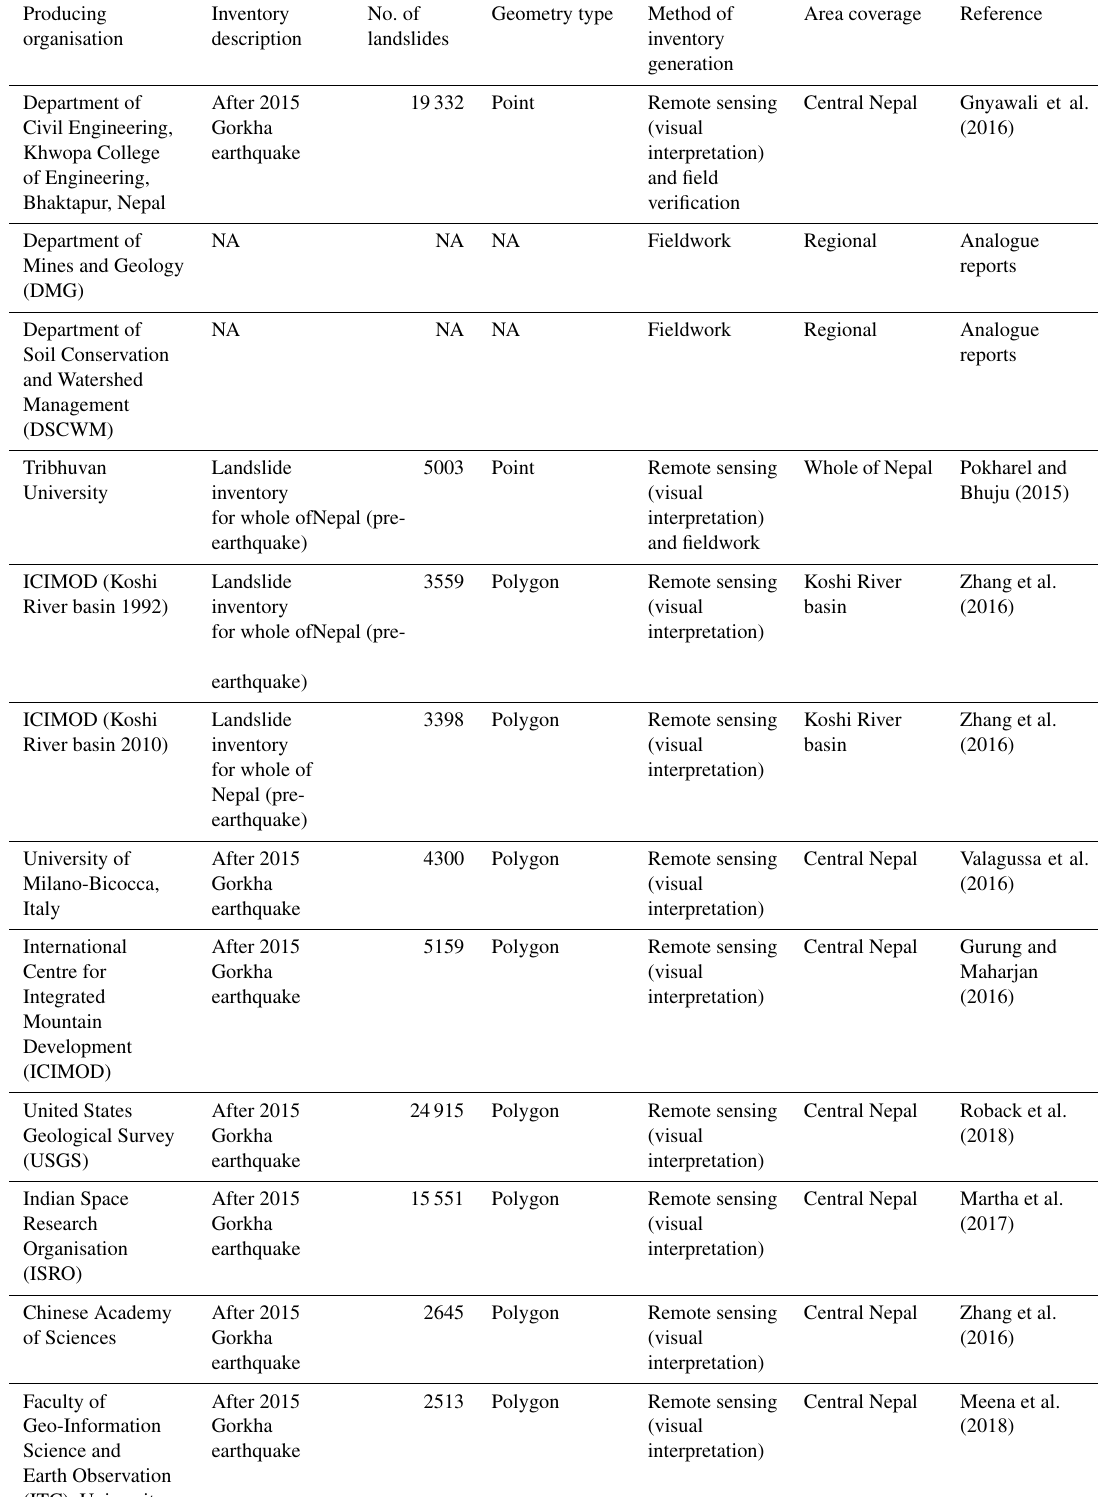
Table 1. Landslide inventories in Nepal. Producing